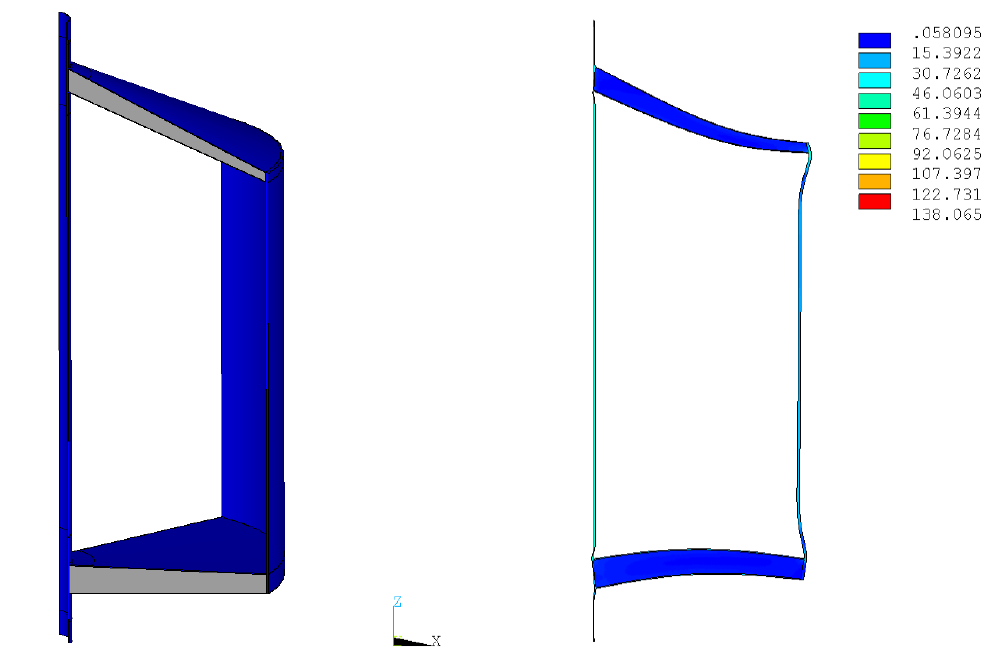
Figure 12. A 3D view of the optimized UBB ( left ) and Von Mises equivalent stress distribution (in MPa) in the structure ( right